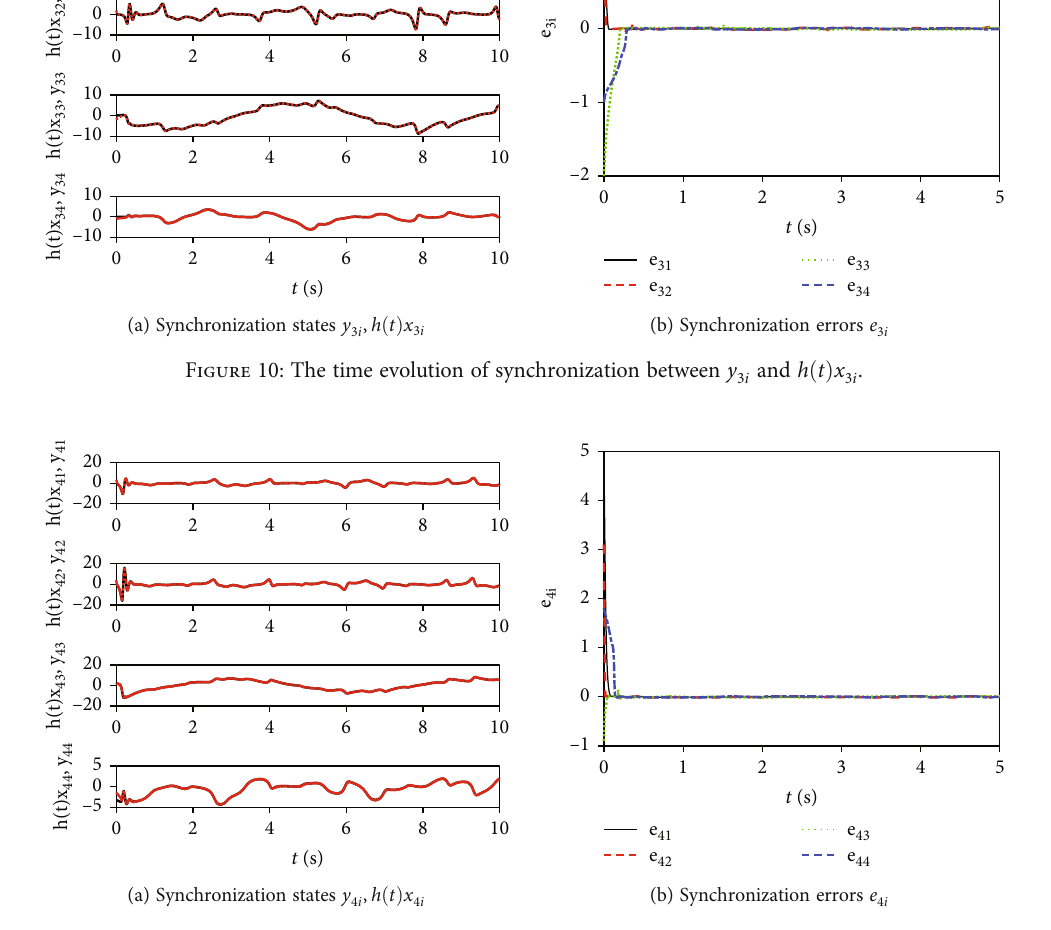
and h ð t Þ x . 4 i 4 i